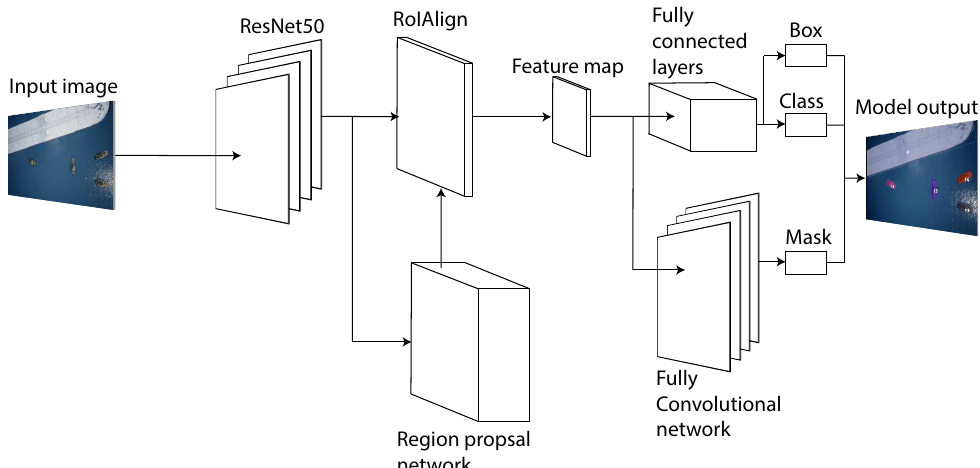
Figure 7. High-level illustration of the architecture of Mask